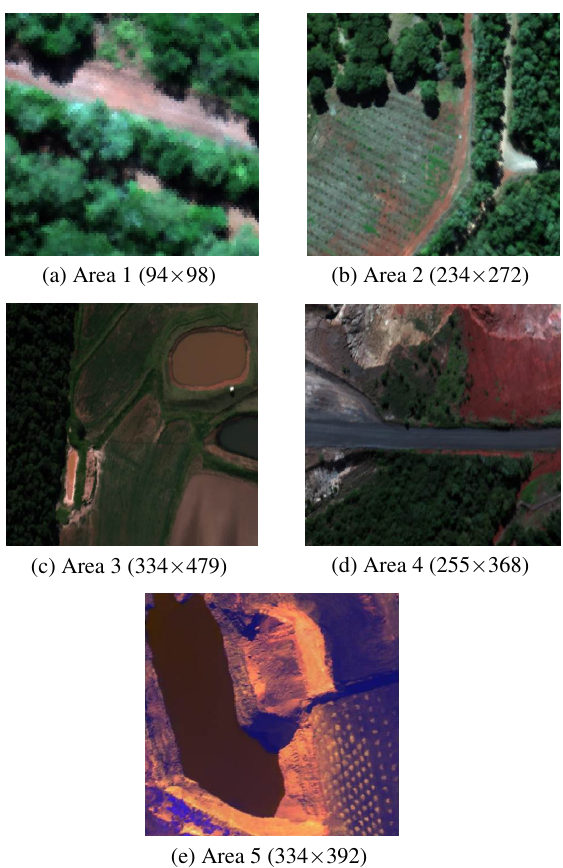
Figure 3. RGB images and dimensions of five different areas. nine different types of signatures by combining different